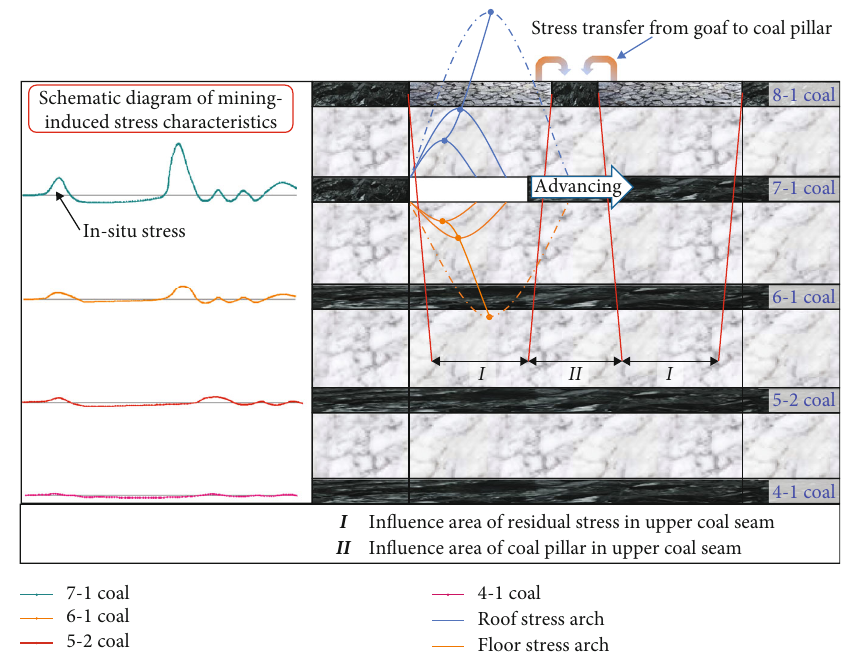
Figure 11: Evolution characteristics of the stress fi eld during coal seam